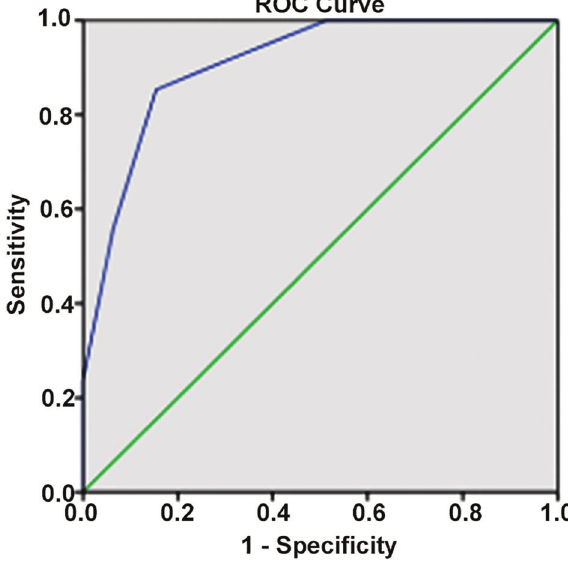
Figure 2. Receiver operating characteristic analysis of the model, where the ROC curve is displayed in blue, and the reference is displayed in green. Table 4. Result of cross